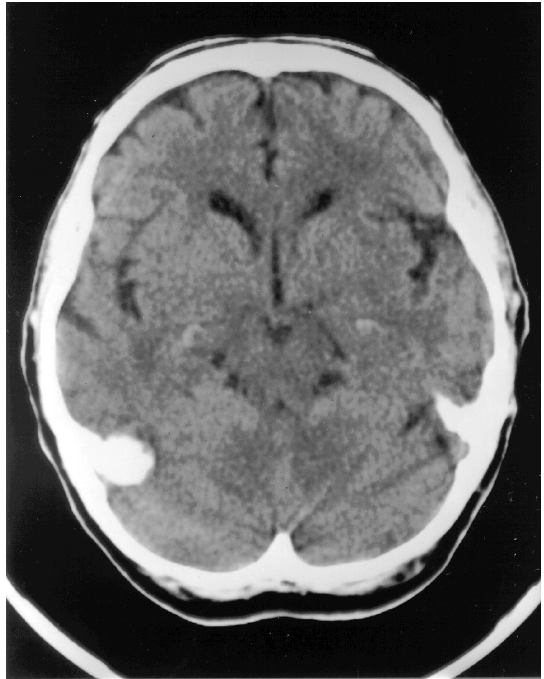
Fig. 1. Brain computed tomography performed when K was 74 years old. A right posterior fossa mass is